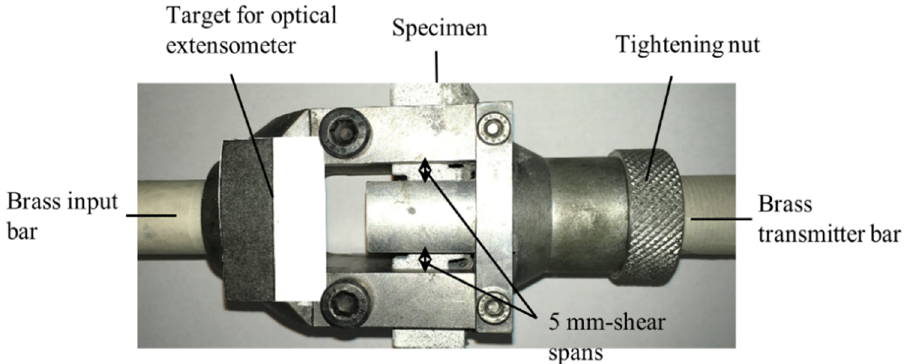
Figure 3. The shear adapter system installed in the SHTB.